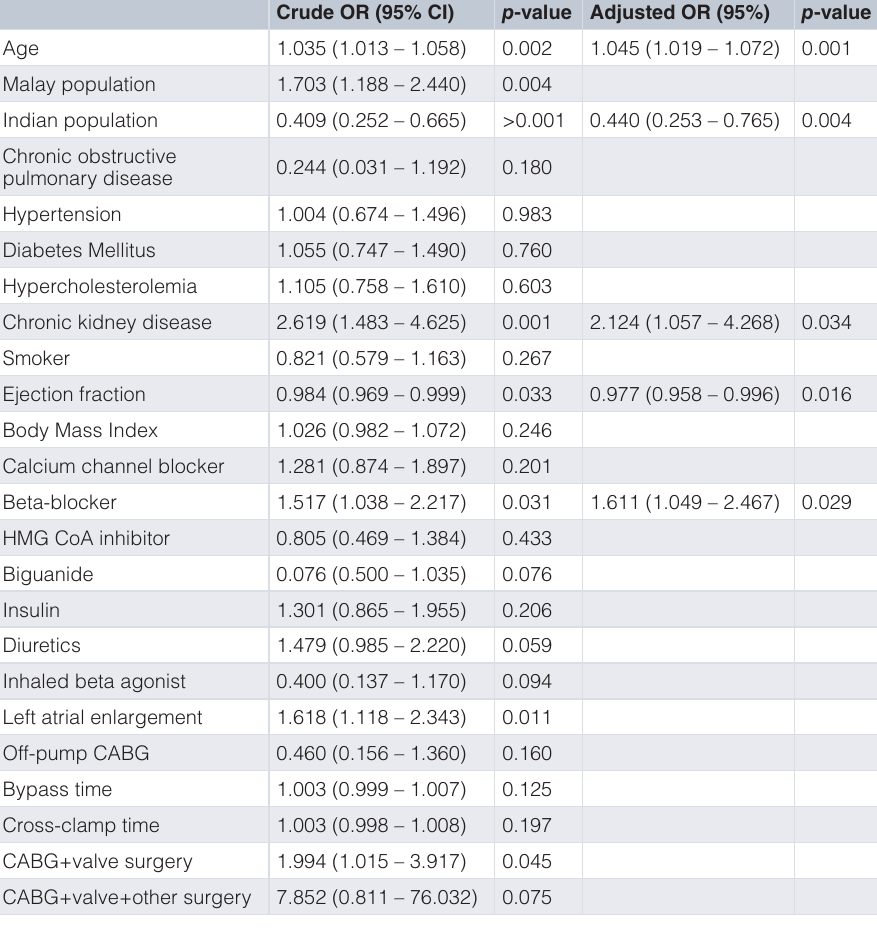
Table 7. Relationship between post-operative atrial fibrillation (POAF) and selected variables before and after adjustments. CABG, coronary bypass